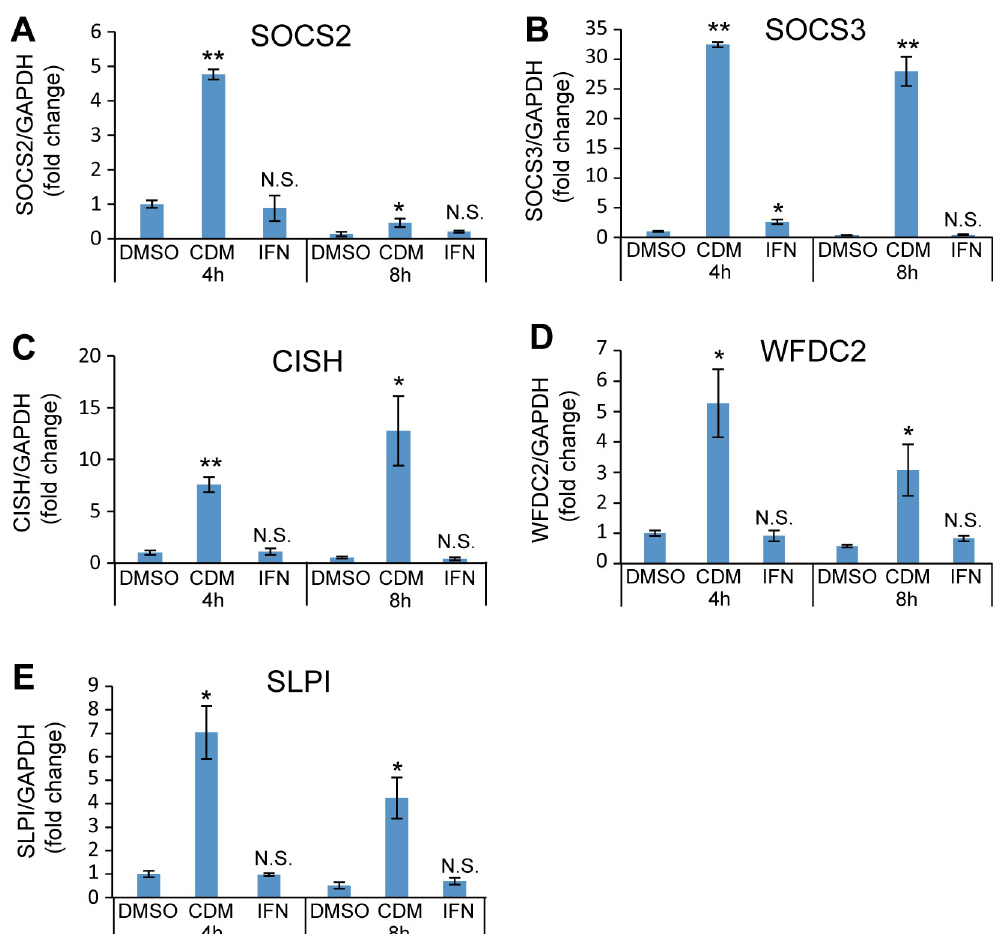
Fig 7. qPCR analysis of CDM-3008-specific genes. (A-E) mRNA expression levels of SOCS2 (A), SOCS3 (B), CISH (C), WFDC2 (D), and SLPI (E) were compared at 4 h and 8 h of treatments. The error bars in A-E indicate S.D. (n = 3). �